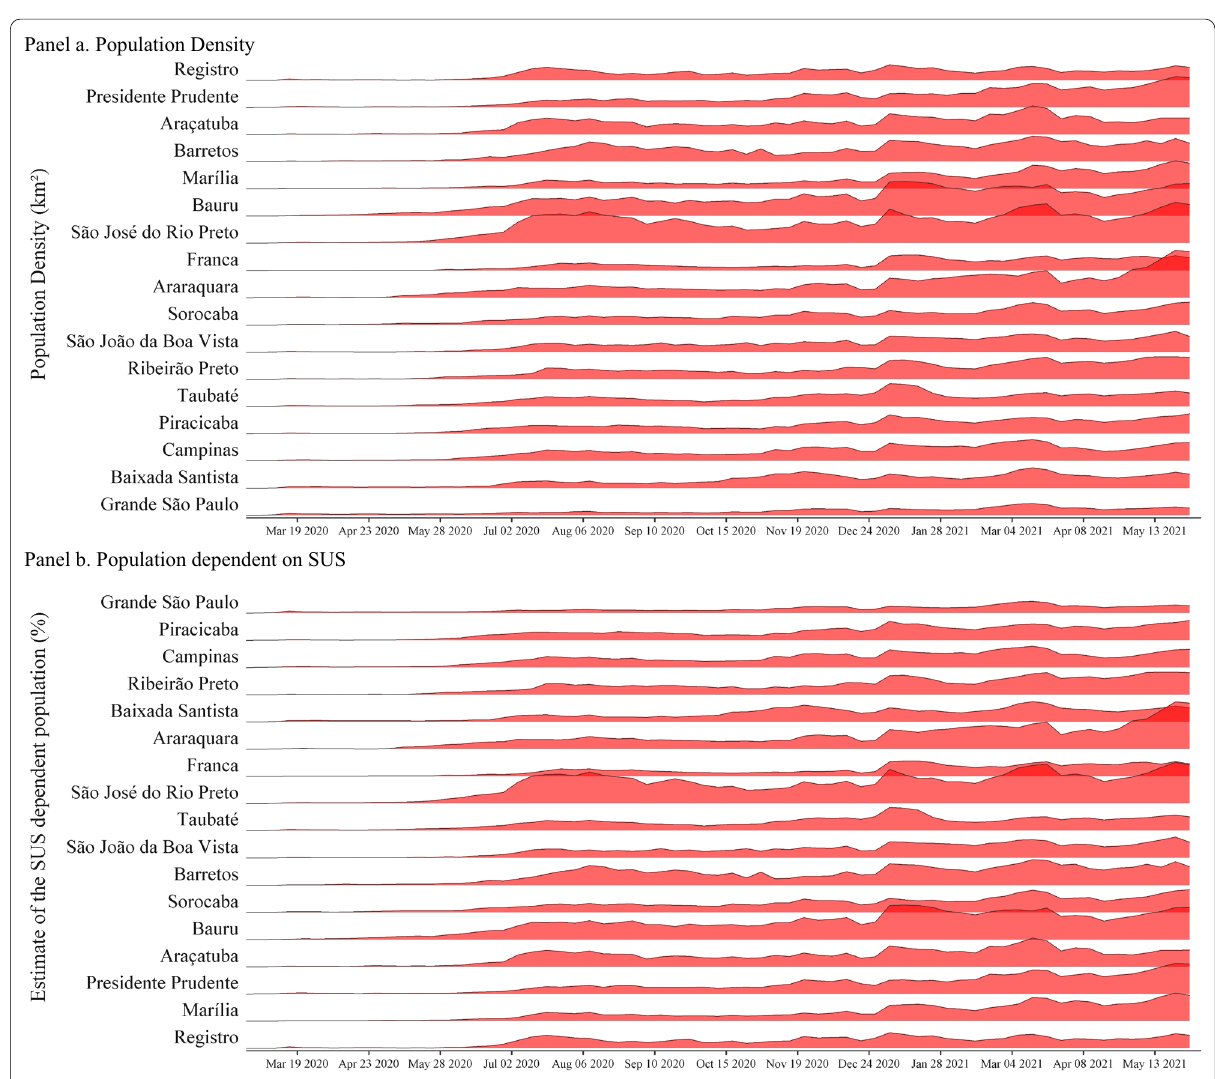
Fig. 4 Variation in Testing per 100,000 and Sociodemographic Indicators across Epidemiological Weeks in the Regional Health Departments. Notes Data from RHDs of São Paulo State, Brazil, from March 1, 2020 to June 5, 2021. RHDS ranked from lowest to highest in each